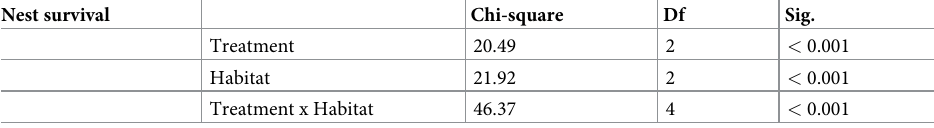
Table 5. Nest survival in relation to treatment, habitat and the interaction between treatment and habitat.